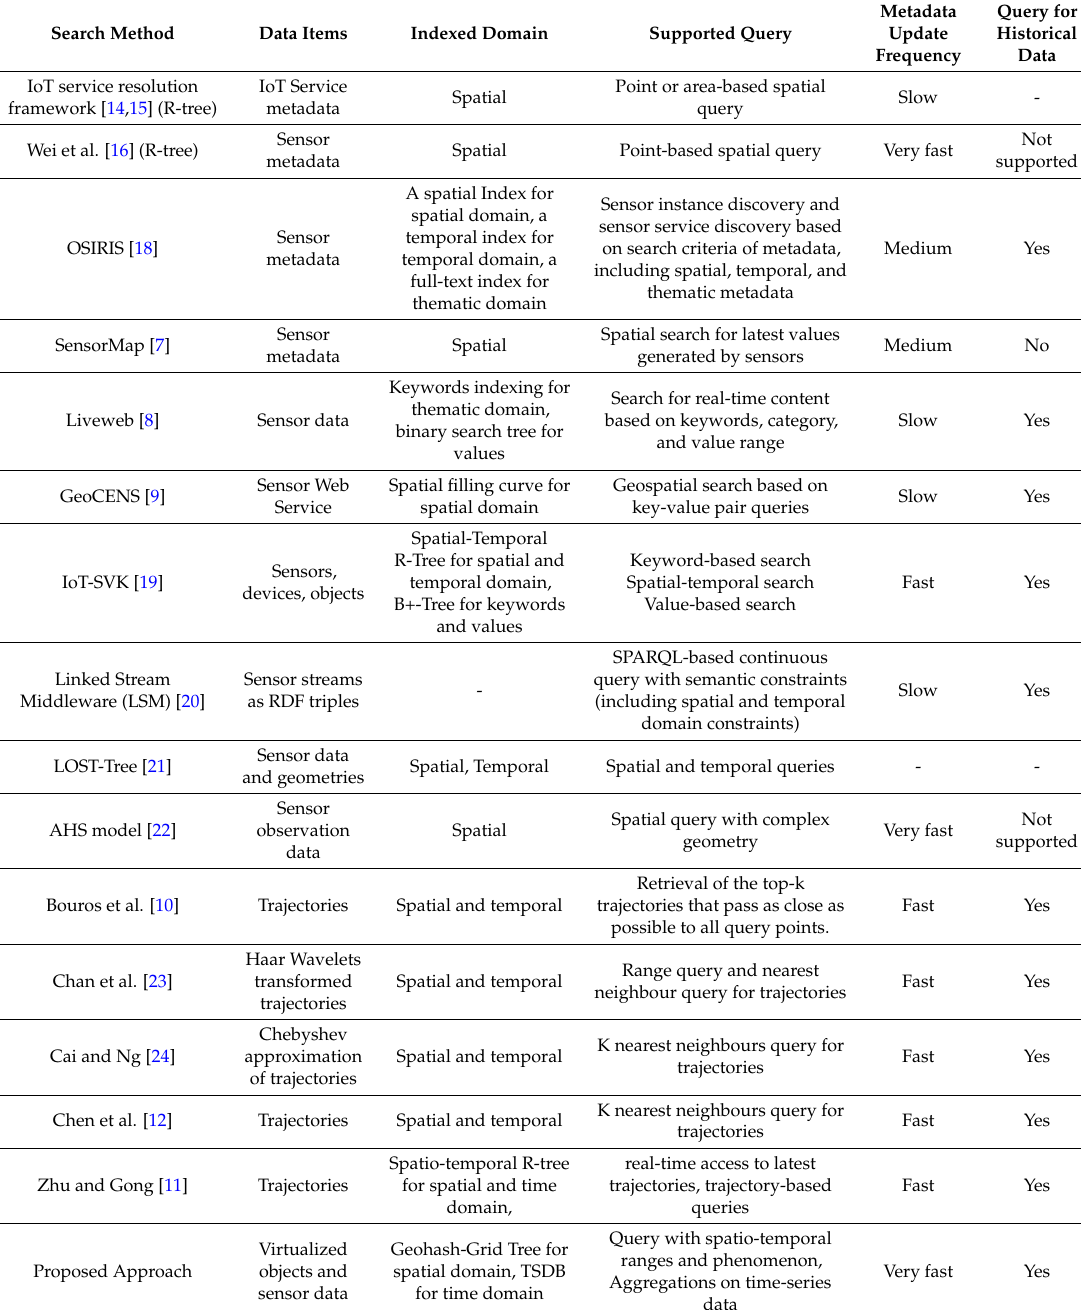
Table 2. Comparison Table of Related